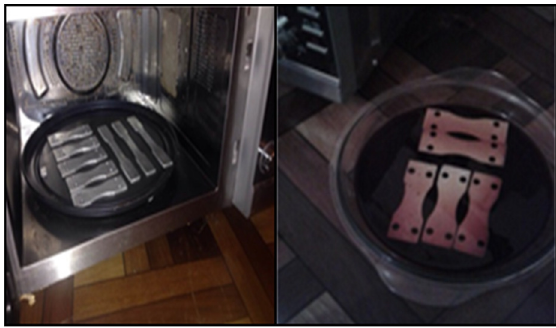
Fig. 1. Microwave Furnace with Sample.